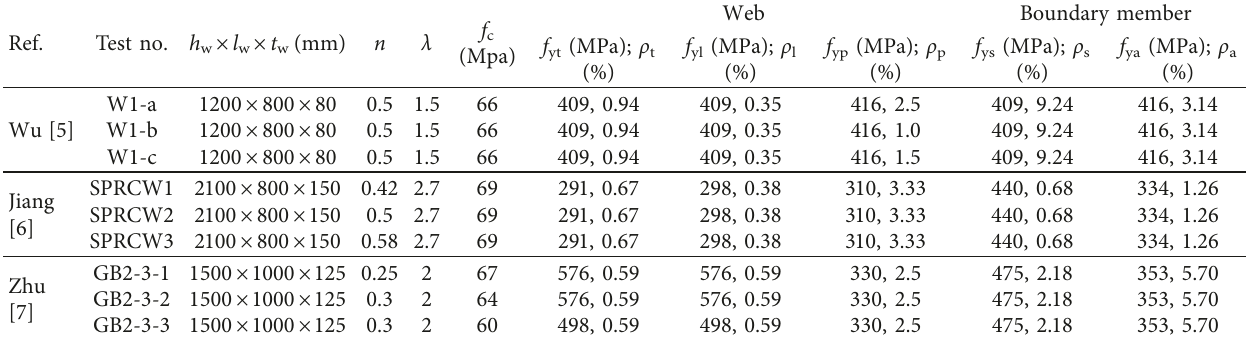
Table 1: Detailed parameters of